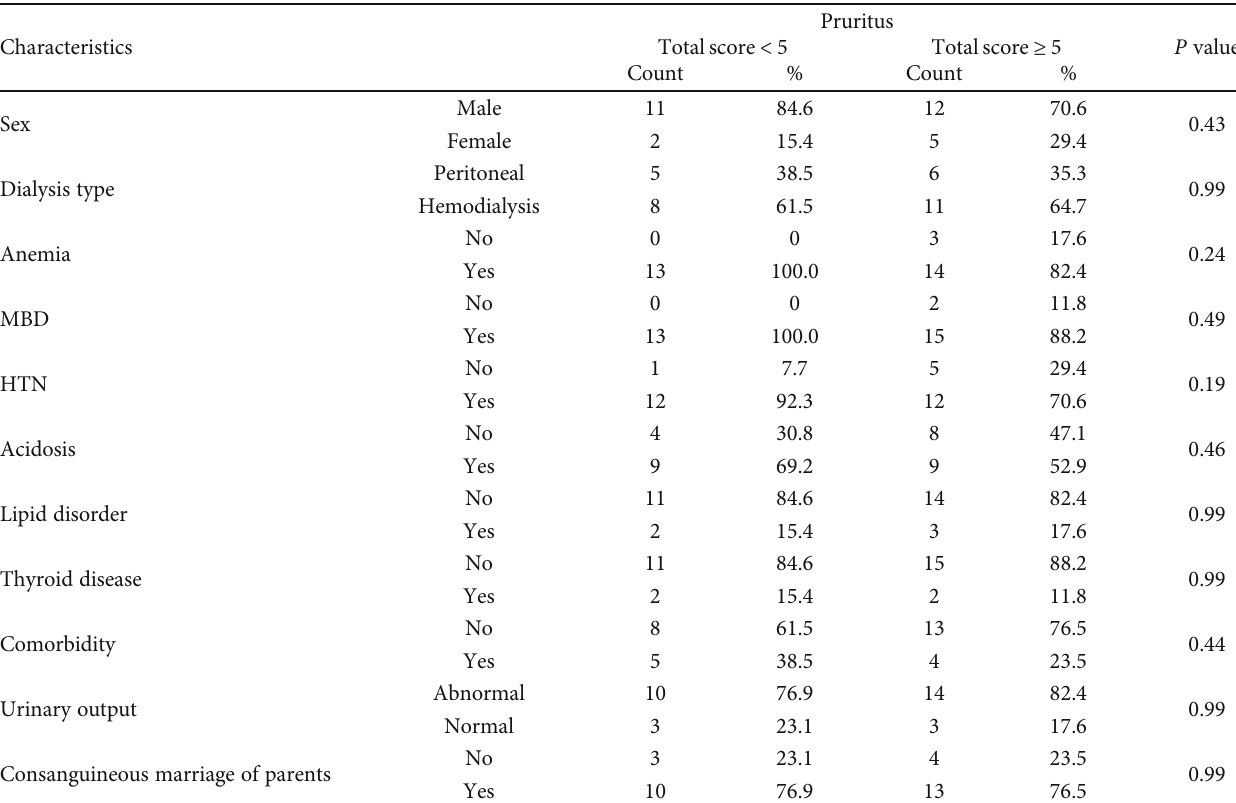
Table 3: Distribution of general characteristics of chronic kidney disease (CKD) children with pruritus according to the total pruritus score.